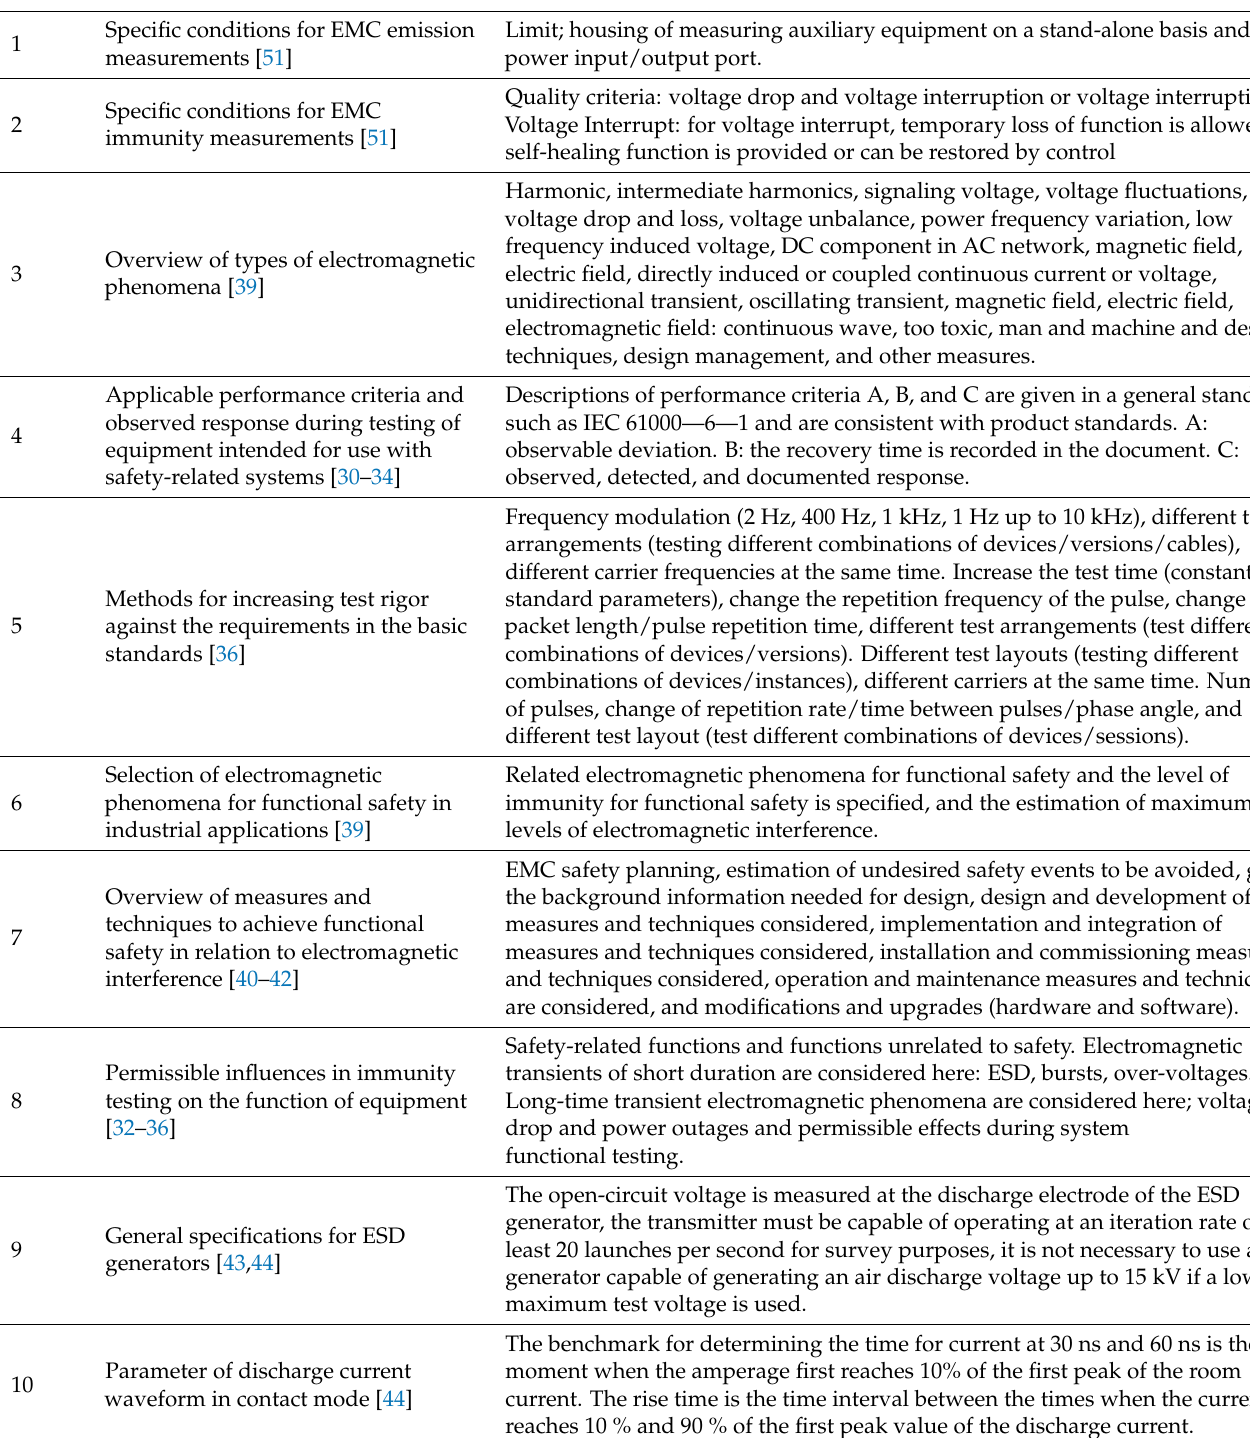
Table A1. A brief summary of the specific conditions of